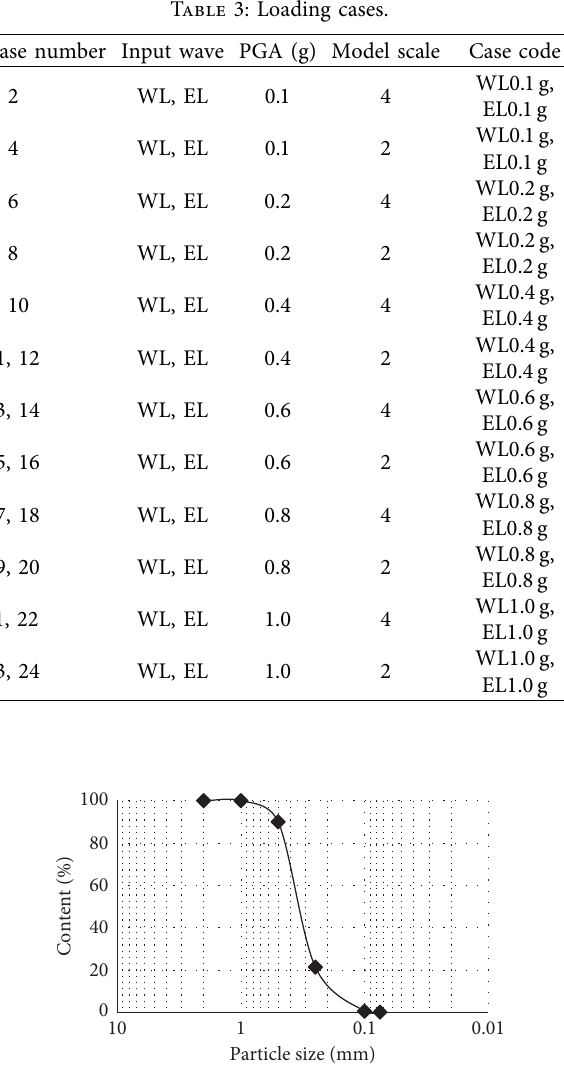
Figure 4: Grain size distribution